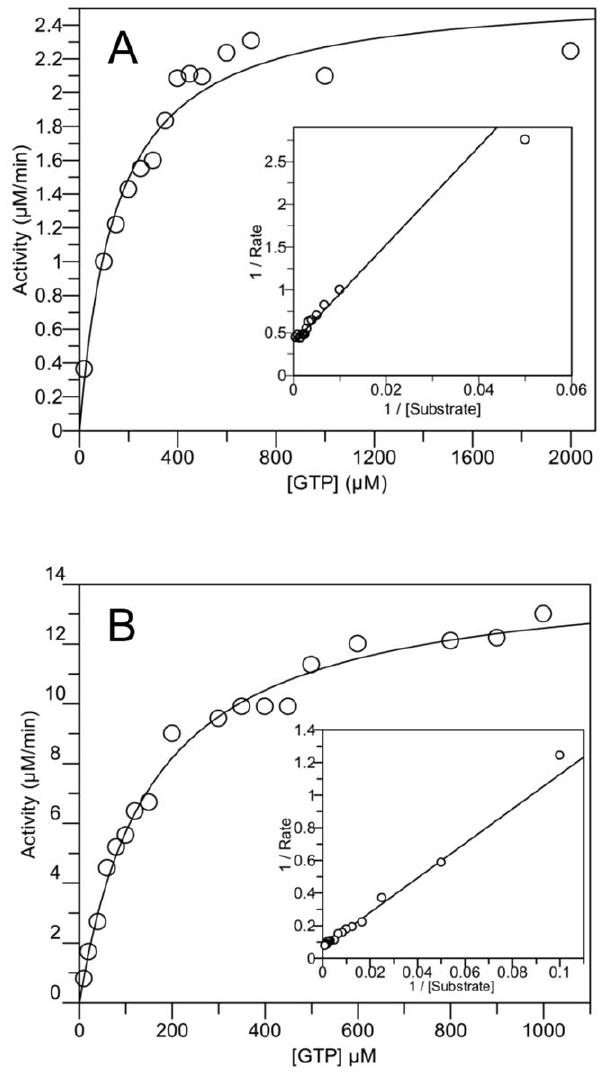
Figure 2. GTPase activity of EngA as a function of increasing concentrations of GTP. A , in the absence of KCl; B , in the presence of 300 mM of KCl. K M and V max values were determined from iterative nonlinear fits of the Michaelis-Menten equation to the experimental data, using the GraFit 5.0.11 software (Erithacus software) and the fitted curve are shown. The inserts show the Lineweaver-Burk plots of the data. One set of data is shown and similar results were obtained from at least three independent experiments.